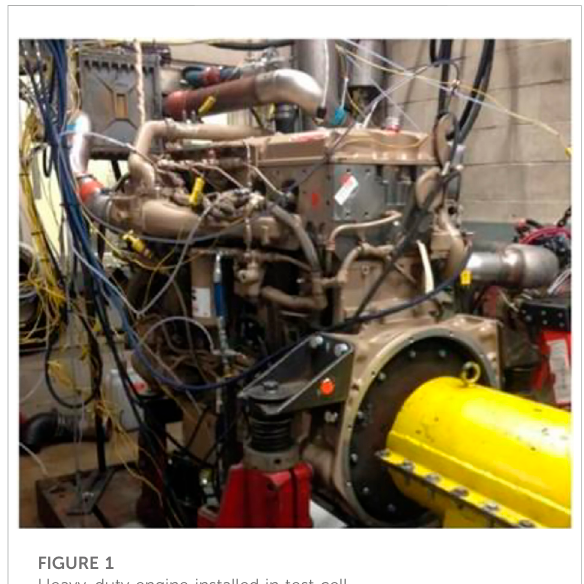
FIGURE 1 Heavy-duty engine installed in test